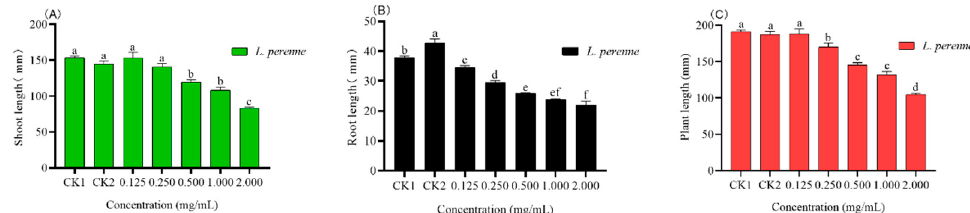
Figure 4. Effect of different concentration of L. pungens essential oil on seedling growth (CK1, blank control; CK2, negative control; ( A ), Shoot length; ( B ), Root length; ( C ), Plant length). Note: different lowercase letters (a–f) represent statistical differences (Tukey’s test p <